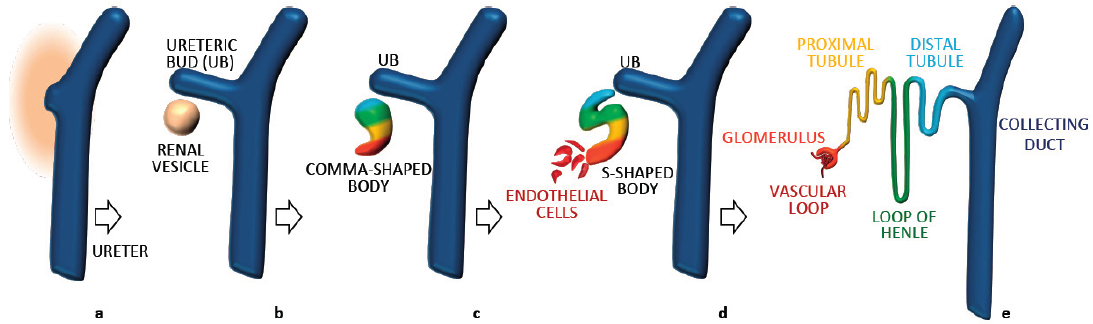
Figure 2. Main developmental steps of the renal nephron. Branching of the ureter generates ureteric buds (UB), surrounded by mesenchymal tissue ( a ); their interaction induces a mesenchymal-to-epithelial transition and generates the renal vescicle ( b ); that develops in a patterned comma-shaped body ( c ); subsequently extending in a tubular S-shaped body ( d ). On one side the S-shaped body makes contact with the ureter, on the other side it connects with migrating endothelial cells that will form the vascular loop within the glomerulus. The patterned expression of specific transcription factors in each tract of the S-shaped body generates the different structures of the mature nephron (see color code ( e